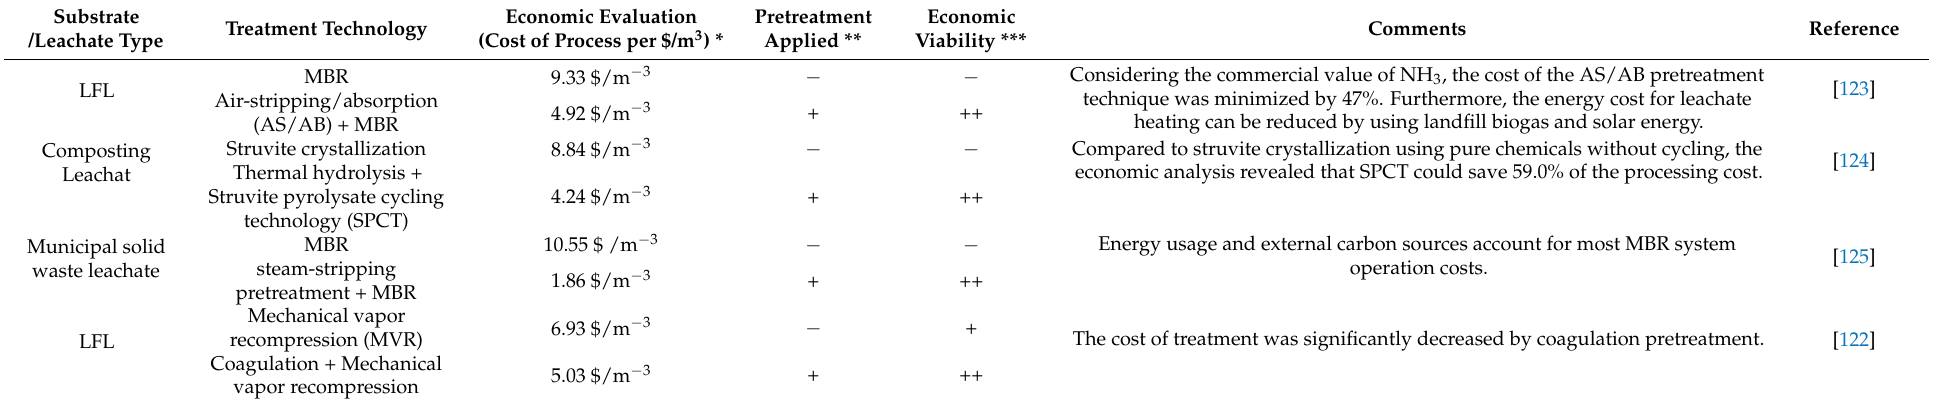
Table 4. Techno-economical evaluation of anaerobic digestion of leachate with various pretreated